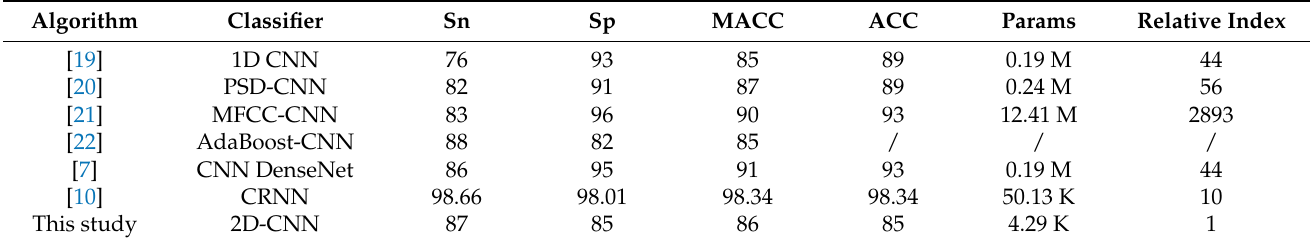
Table 3. Comparison of results among different methods